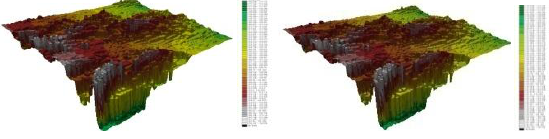
Figure 13: 3D view of the DEM created using IDW of power of two from spot elevation measurements.